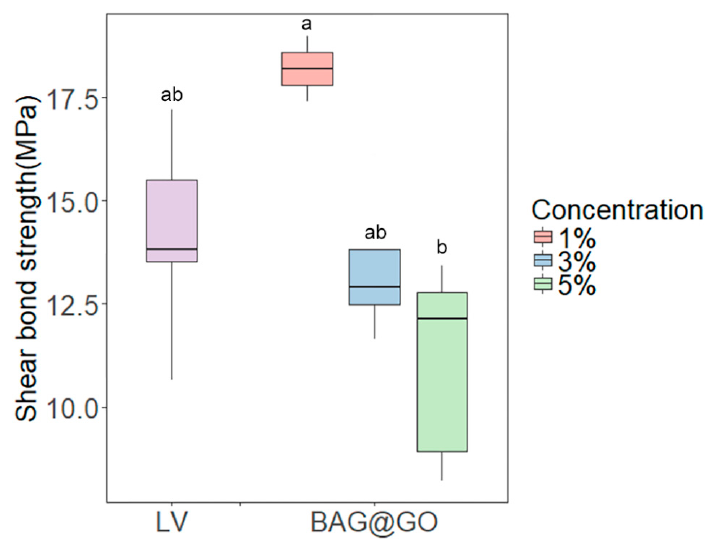
Figure 4. Shear bond strength comparison of orthodontic bonding adhesive containing LV and different weight percentages of BAG@GO. The same letters indicate no statistically significant difference between the groups ( p < 0.05) by Duncan’s multiple comparison test. Error bars are shown ± standard deviation.